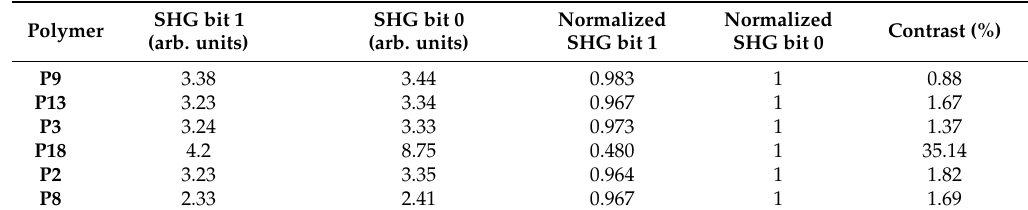
Table 3. SHG values for bit 1 and bit 0 and contrast for different coumarin-based polymers.